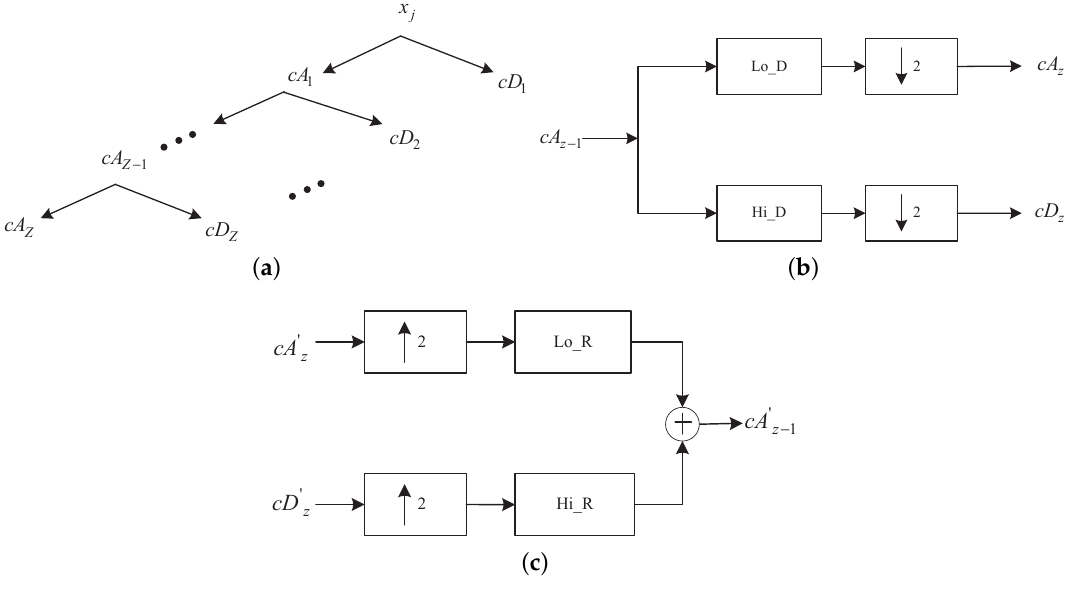
Figure 3. Schematic of wavelet decomposition. j = 0, ..., J − 1 indicates the decomposition level and cA 0 = x j . ( a ) Structure of the J level decomposition tree; ( b ) operation in each level to decompose the signal; ( c ) operation in each level to reconstruct the